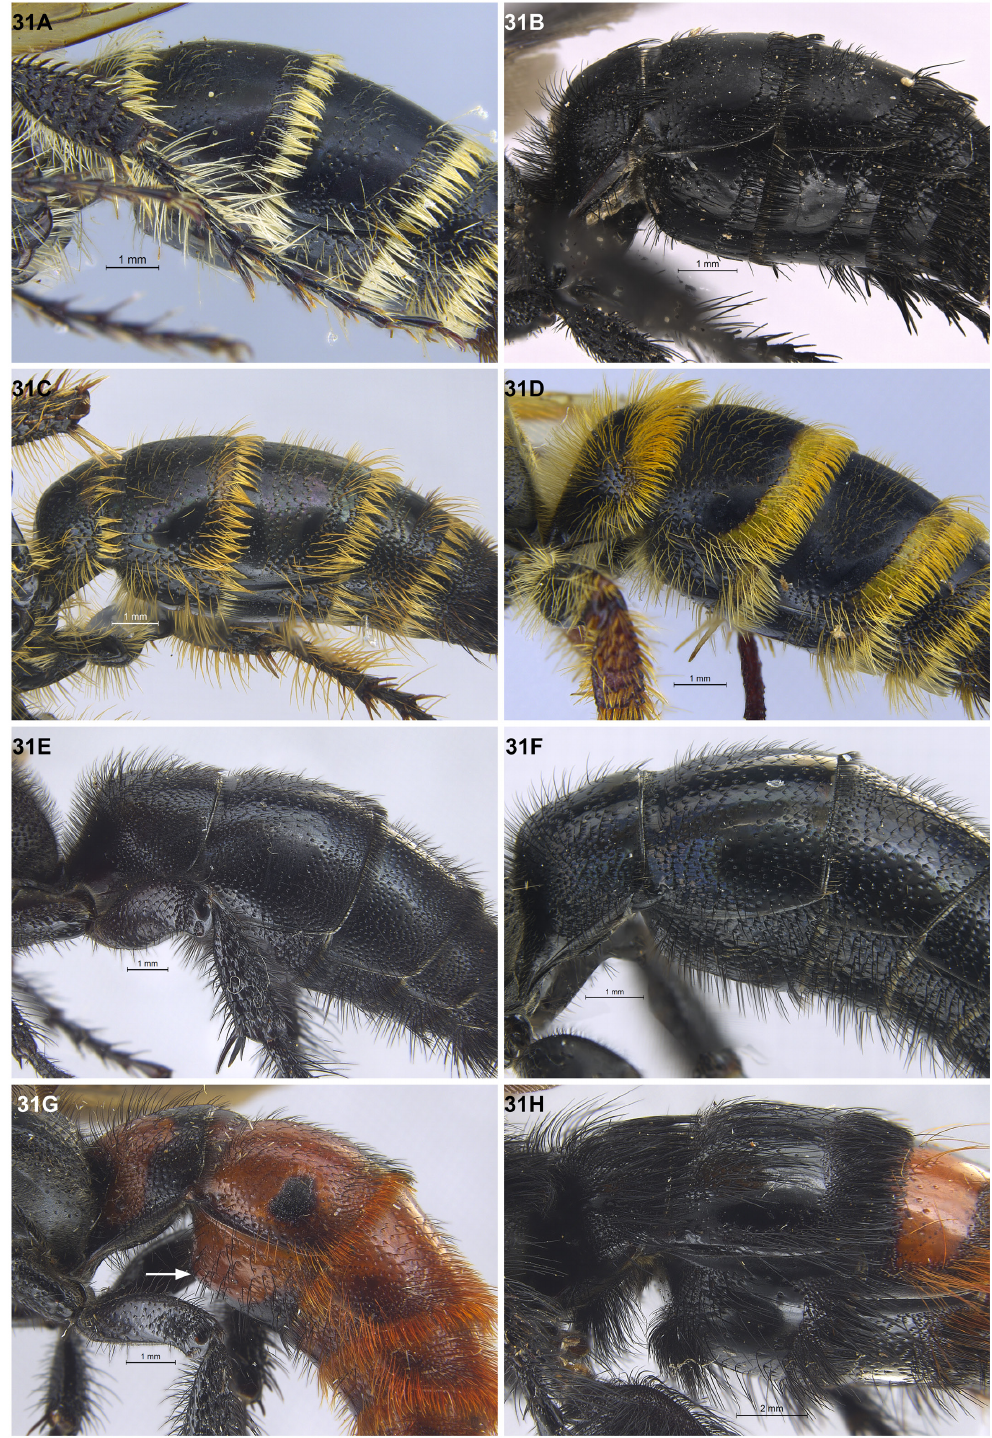
Fig. 31. Females, T1–T3, lateral view. A . Campsomeriella annulata annulata (Fabricius, 1793). B . Camps. collaris (Fabricius, 1775) . C . Megacampsomeris formosensis chinensis Betrem, 1941. D . Phalerimeris phalerata phalerata (de Saussure, 1858). E . Austroscolia ruficeps ruficeps (Smith, 1855). F . Carinoscolia junnanensis (Betrem, 1928). G . Liacos erythrosoma (Burmeister, 1854). H . Megascolia azurea (Christ,